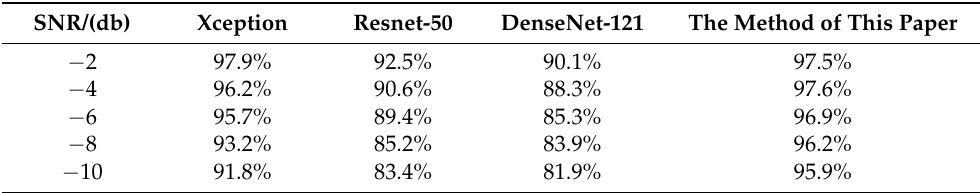
Table 9. Comparison between Different